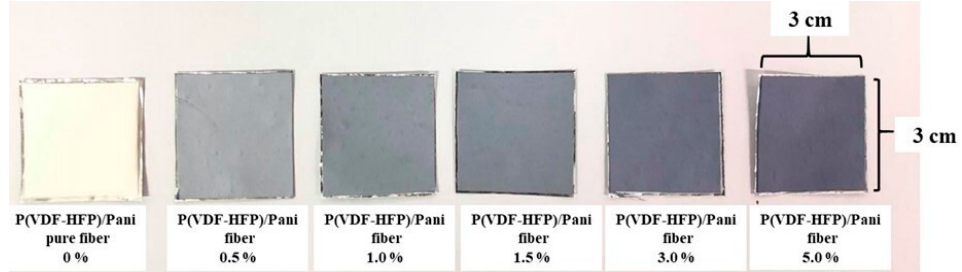
Figure 3. Photograph images of pure P(VDF-HFP) and P(VDF-HFP)/PANI composite nanofibers (0.0, 0.5, 1.0, 1.5, 3.0 and 5.0 wt%).